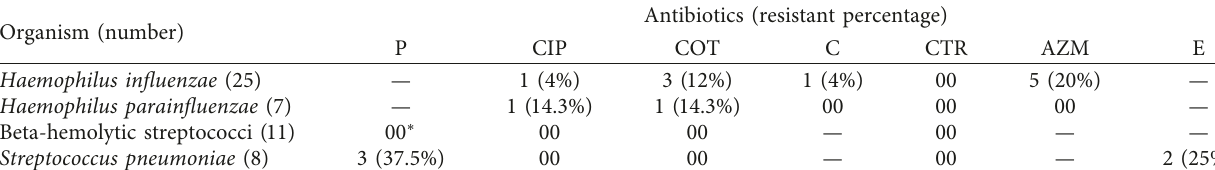
Table 4: Antibiotic resistance pattern of pharyngeal isolates.